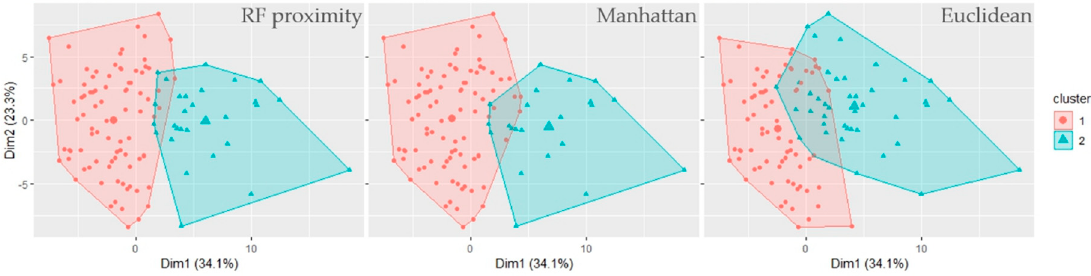
Figure 4. The cluster plots of three similarity measures of trees based on Normalized Difference Water Index (NDWI). Cluster 1 represents drought-affected trees and cluster 2 represents non-drought affected trees.